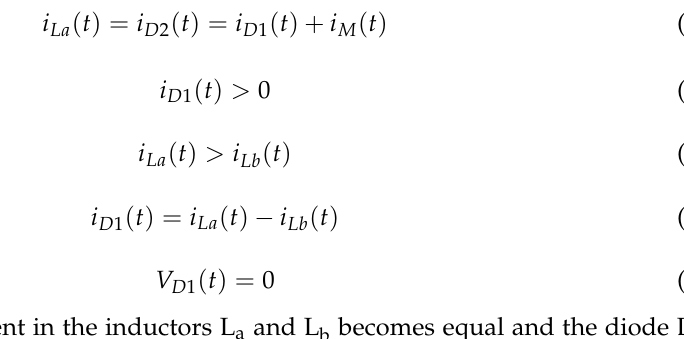
and the diode D 1 is forward-biased.